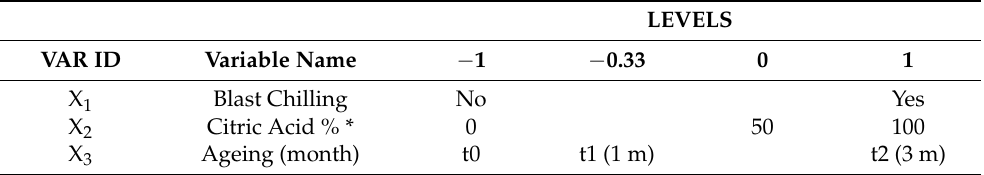
Table 1. Experimental plan: variables and